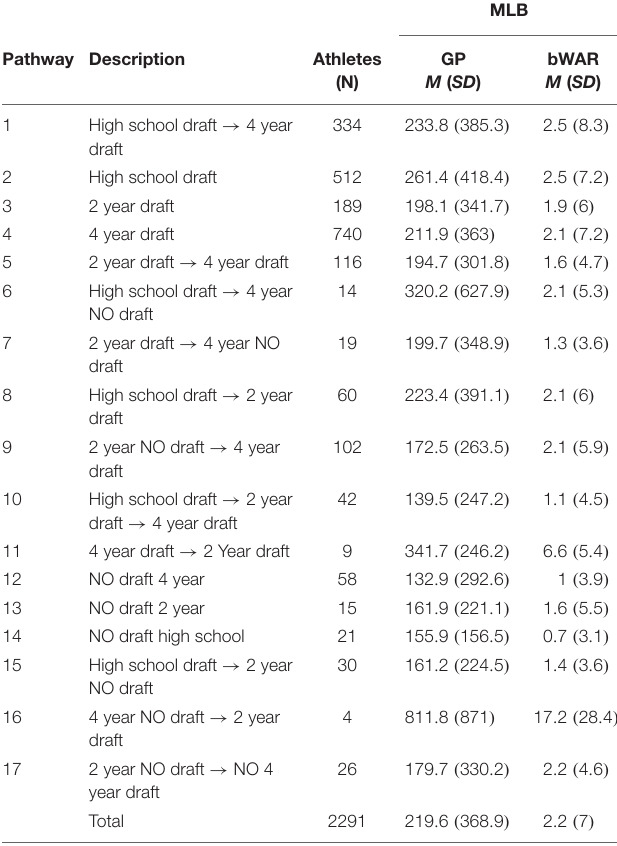
TABLE 1 | General pathways and their MLB